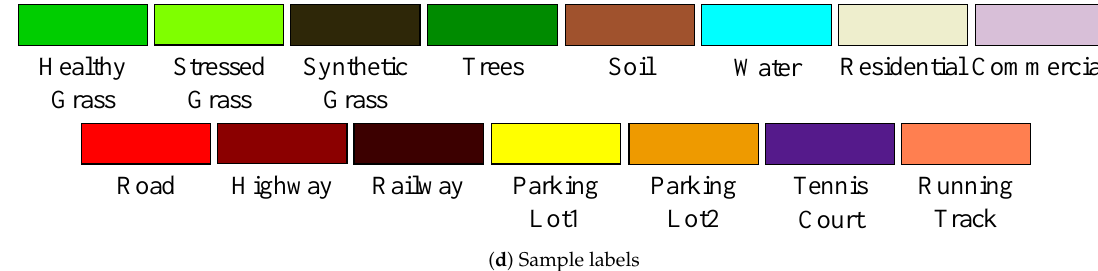
Figure 2. The 2012 Houston dataset.